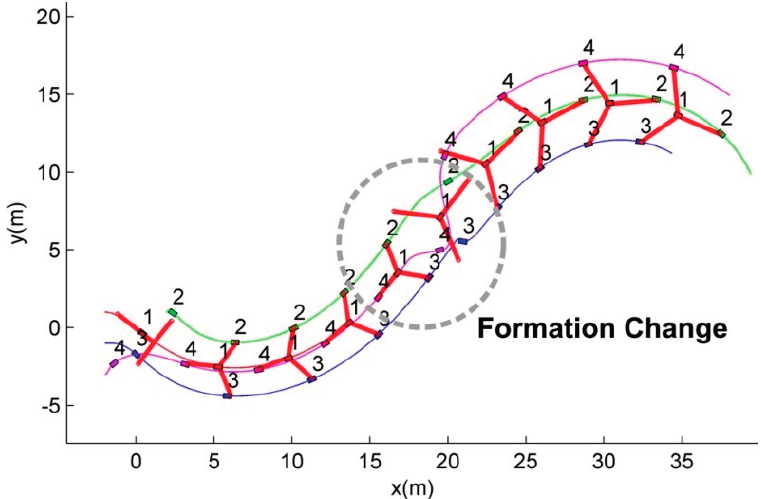
Figure 8. The route of the robots in the formation changing situation.